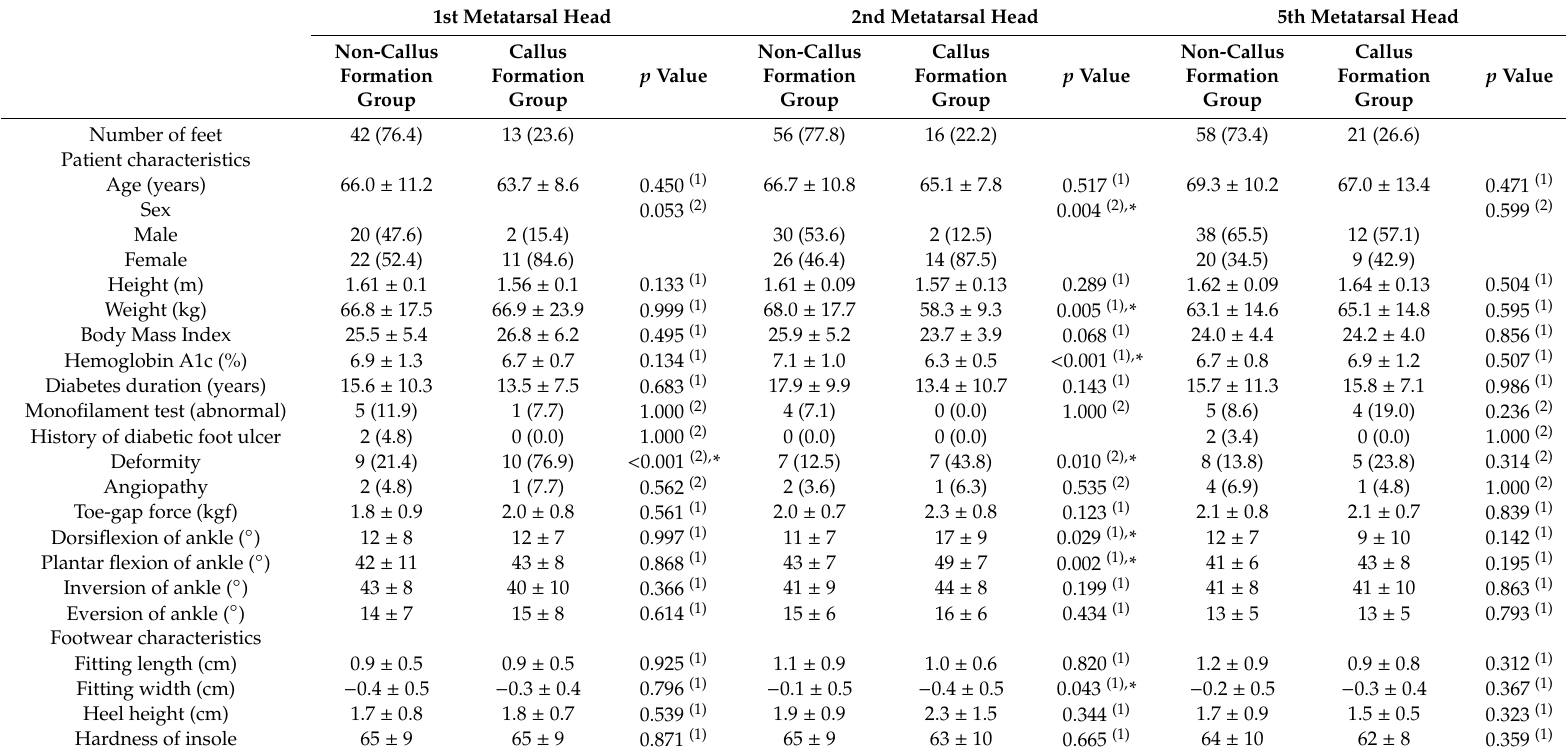
Table 1. Patient and footwear